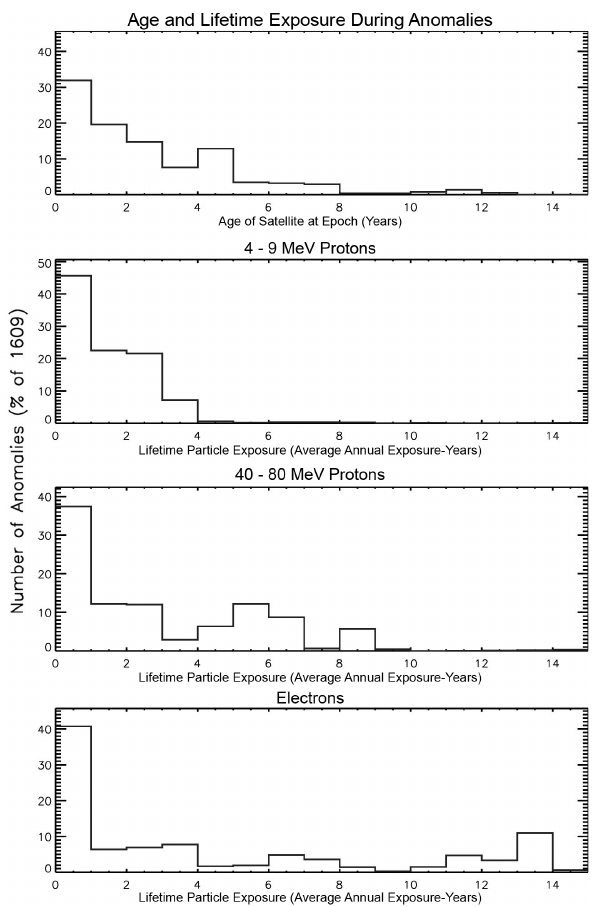
Fig. 3. Distribution of satellite age when an operational anomaly oc- cured (top frame), perceived age calculated from 4–9MeV protons (2nd frame from top), perceived age calculated from 40–80MeV protons (3rd frame from top), and perceived age calculated from ≥ 2MeV electrons (bottom frame).